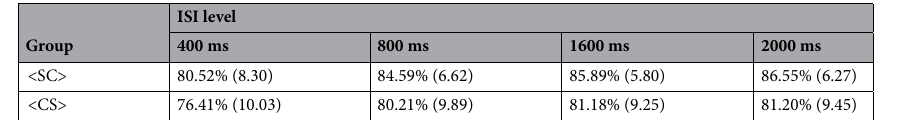
Table 1. Accuracy. Mean accuracy and the standard deviation (SD, in parentheses) for each group and each ISI level. In both groups, participants had their worst performance at the ISI 400 condition. However, mean accuracy values are lower for the <CS> group than for the <SC>